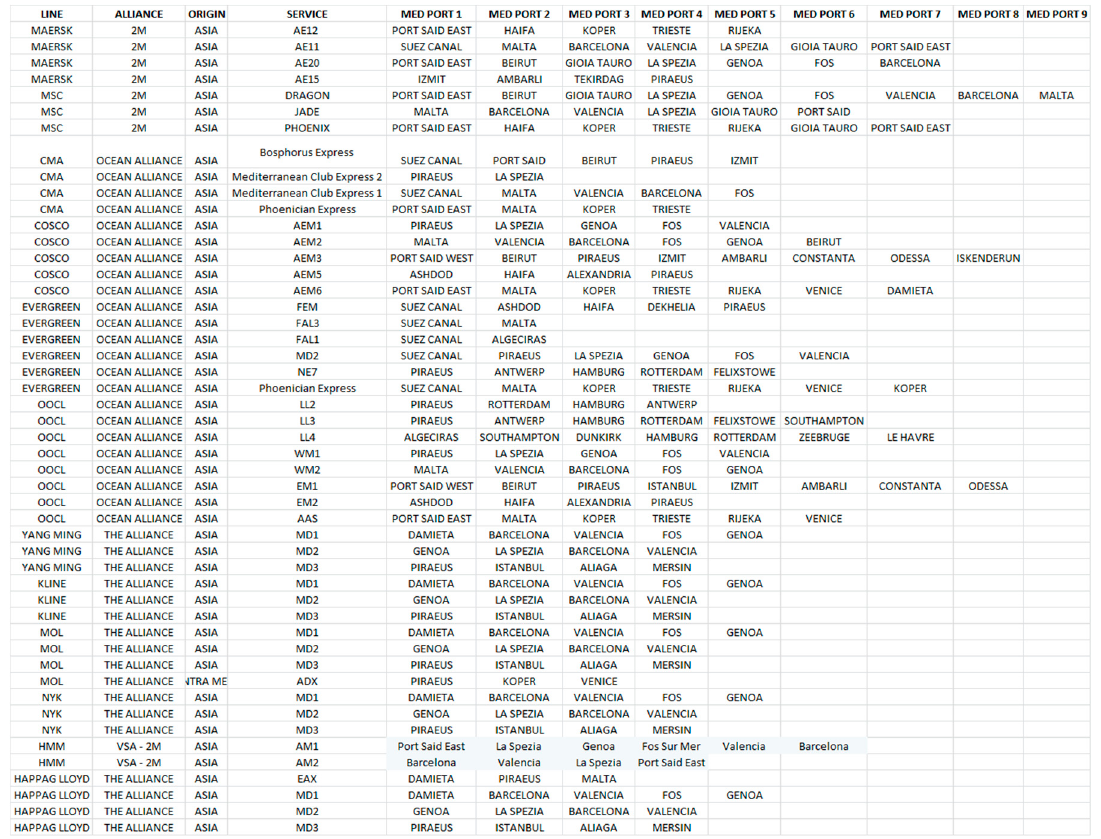
Figure A1. Liner service as of September 2017.